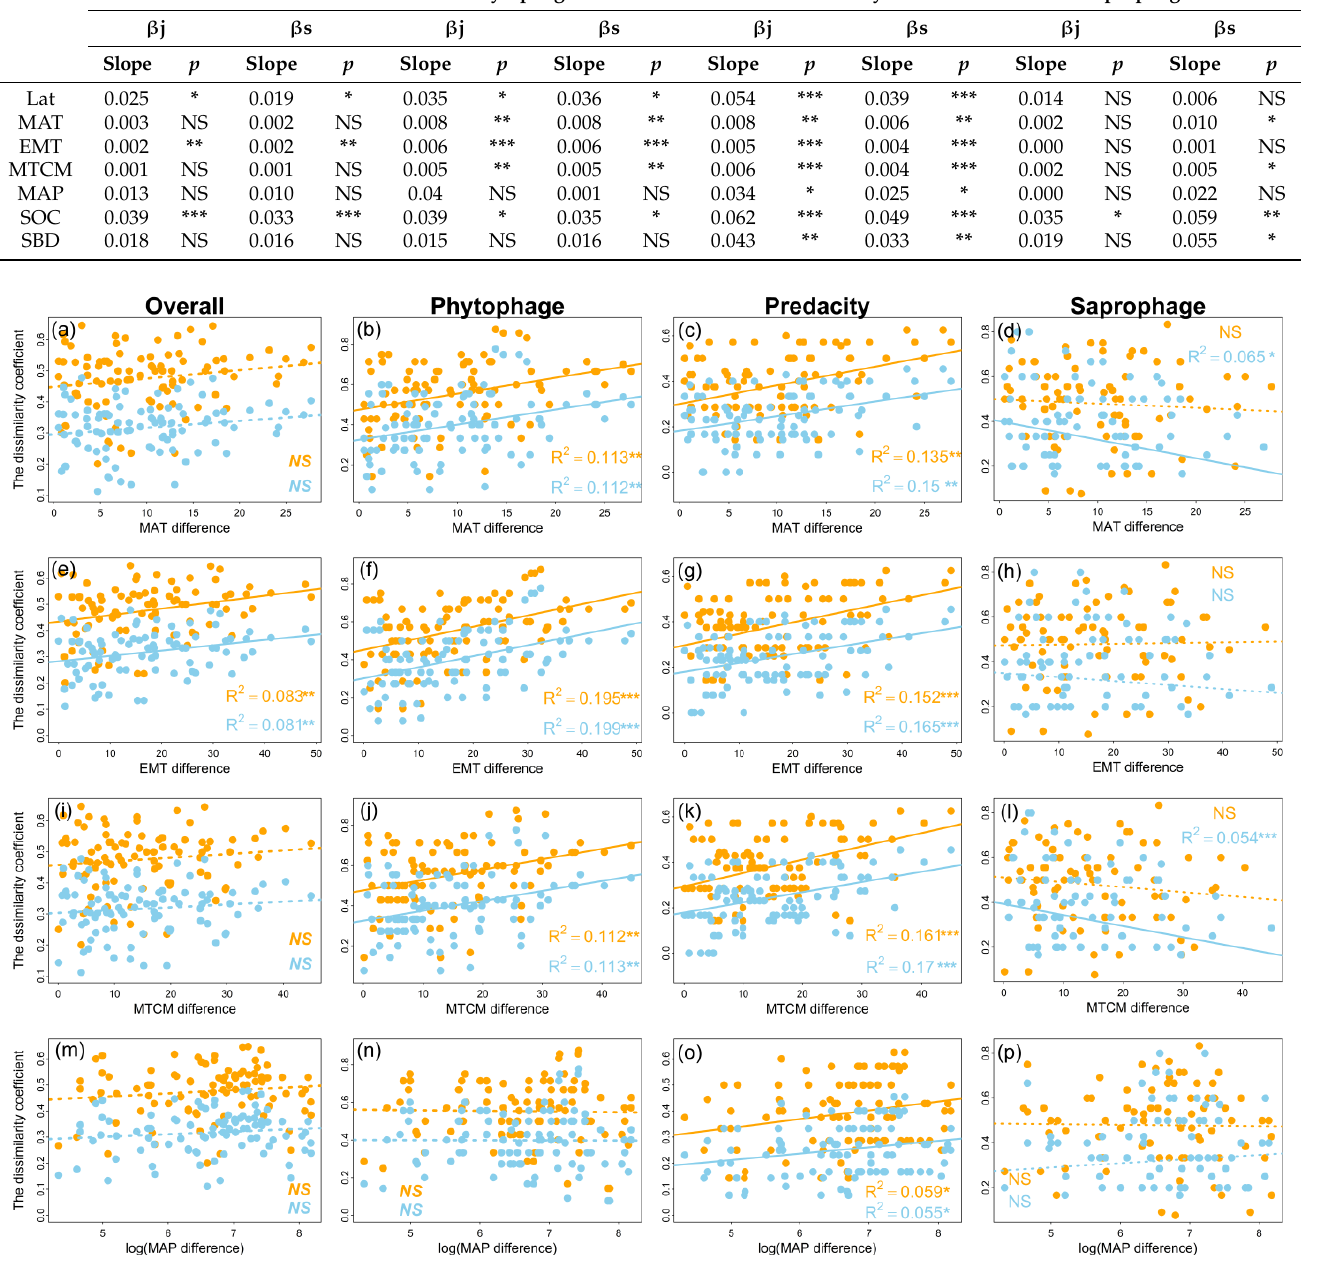
Figure 6. Patterns of overall ( a ), ( e ), ( i ) and ( m ); phytophagous ( b ), ( f ), ( j ) and ( n ); predatory ( c ), ( g ), ( k ) and ( o ) and saprophagous ( d ), ( h ), ( l ) and ( p ), fauna in different sampling sites with environmental differences in East Asia. Orange dots and lines represent βj and blue dots and lines represent βs ; n = 91; “*”, “**” and “***” represent p ≤ 0.05, 0.01 and 0.001, respectively. “NS” indicates p > 0.05. (Note: MAT = mean annual temperature, MTCM = mean temperature of the coldest months, EMT = extreme minimum temperature and MAP = mean annual precipitation).